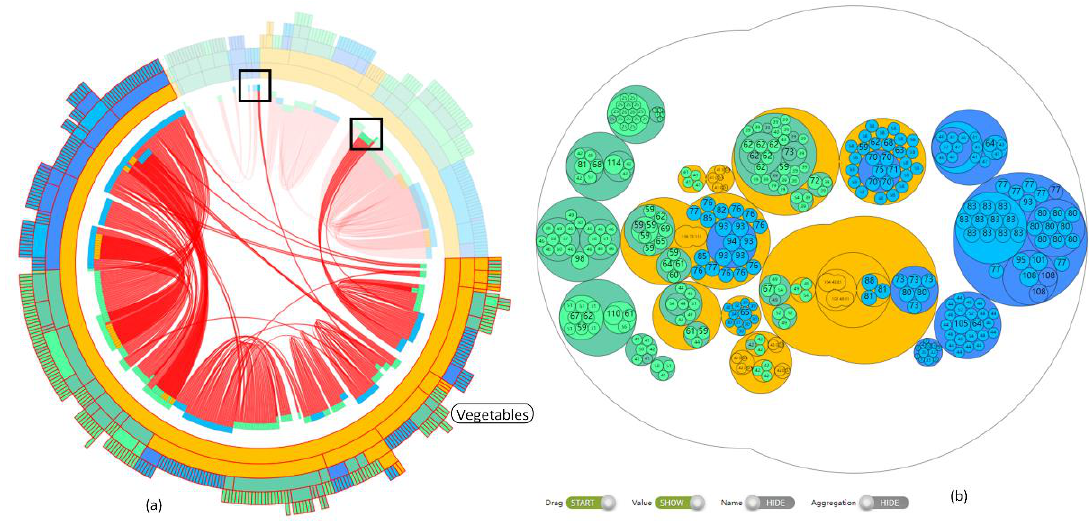
Figure 12. Classification of “Vegetables”. ( a ) Visualization of node similarity and classification hierarchy in SECG. ( b ) Visualization of attribute values in OCT.